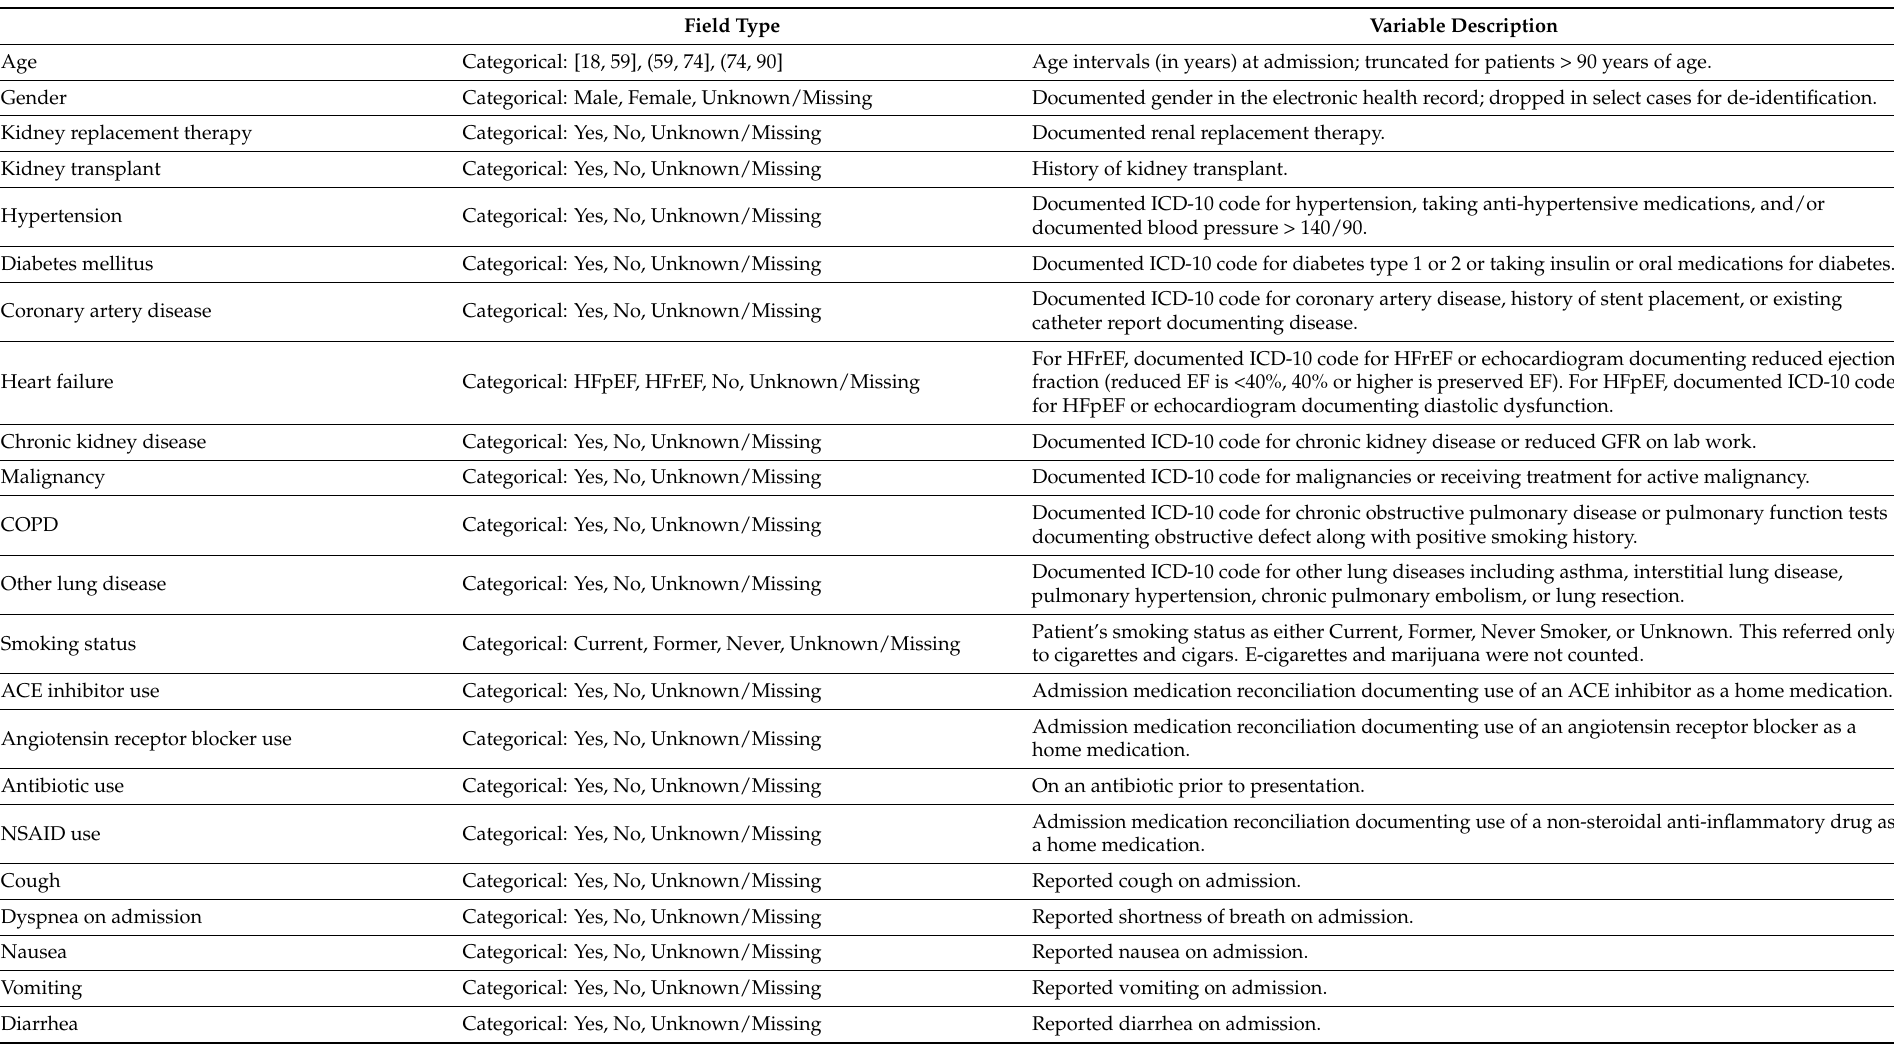
Table 1. Clinical data variables used for